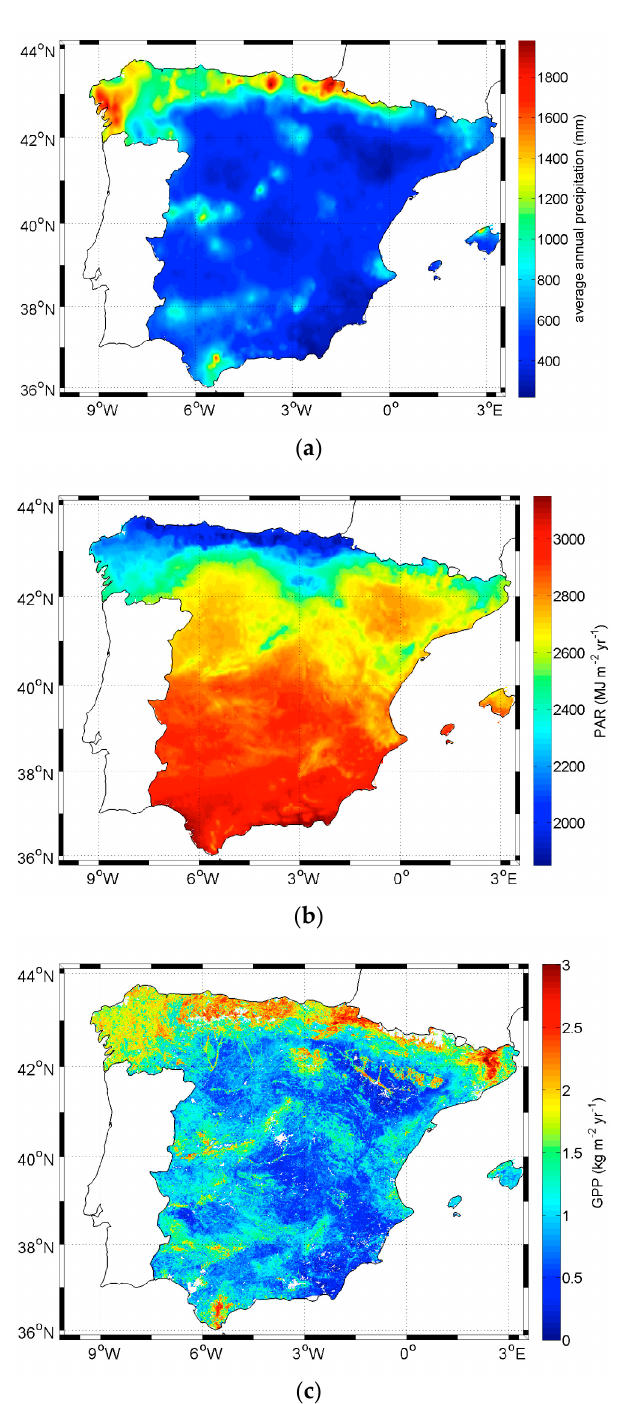
Figure 1. Average annual precipitation ( a ); and average annual PAR ( b ) for the study area using the eight years analyzed in the study (2005–2012); and ( c ) annual reference GPP for